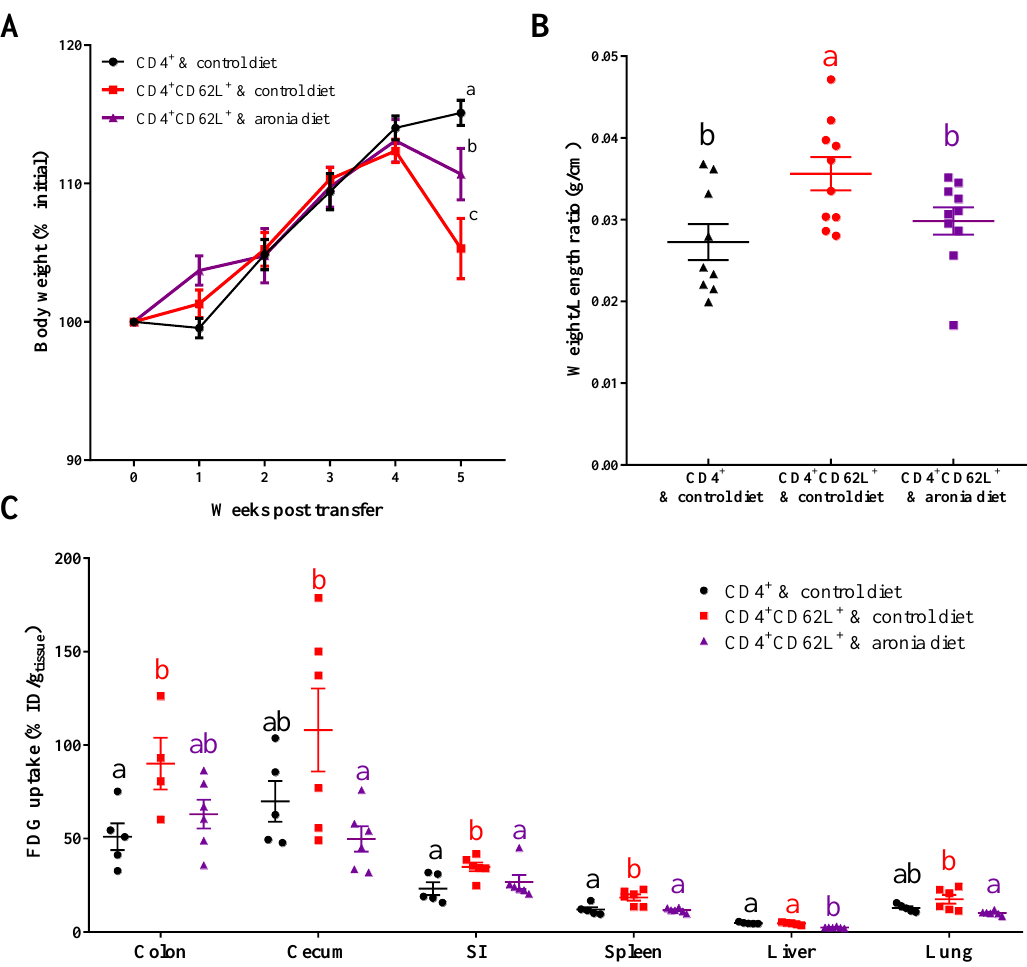
Figure 1. Consumption of 4.5% aronia berry-supplemented diet mitigates wasting induced by T cell transfer colitis in mice. Splenic CD4 + CD62L + cells from C57BL / 6J mice were transferred to Rag1 - / - mice. Mice consumed the AIN-93M diet (colitic control) or aronia-supplemented diet for five weeks. A third group of Rag1 - / - mice received splenic CD4 + cells, consumed AIN-93M diet, and served as the non-colitic control. ( A ) Body weight changes after T cell transfer, as mean percentage of initial body weight at transfer ( n = 9–10 / group). Data bearing di ff erent letters indicate significant within-week di ff erences ( p < 0.05). ( B ) Colon weight / length ratio ( n = 9–10 / group). ( C ) Tissue 2-deoxy-2-[ 18 F]fluoro- d -glucose (FDG) uptakes at 1 h after intravenous injection of approximately 1.85 MBq of FDG ( n = 4–6 / group). Groups bearing di ff erent letters indicate significant di ff erences between treatments ( p < 0.05). Data are means ±